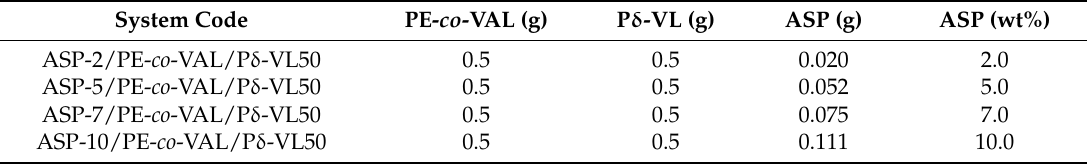
Table 2. Preparation conditions of ASP/PE- co -VAL/P δ -VL50